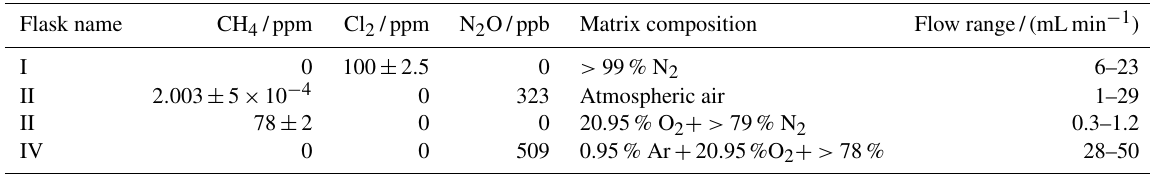
Table 2. Table summarizing experimental conditions.